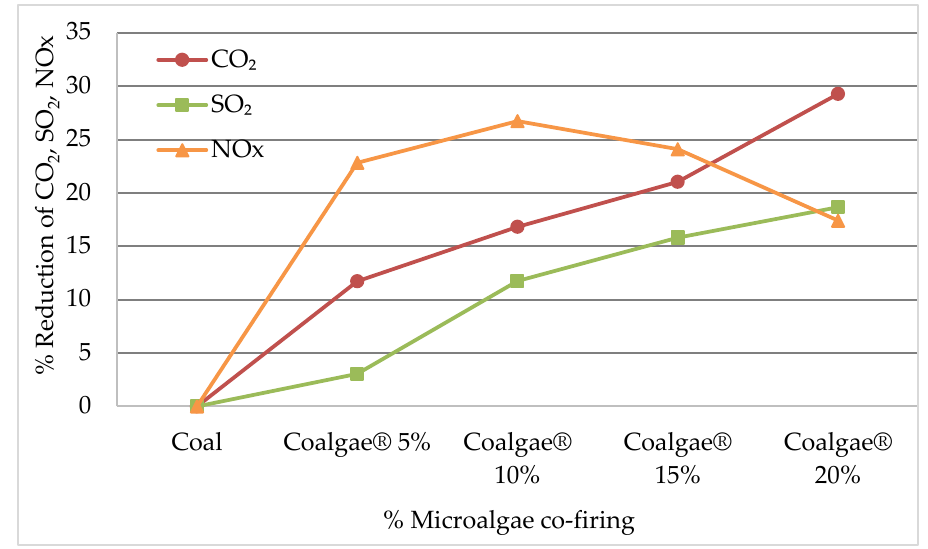
Figure 6. Average concentration of CO 2 in flue gas.